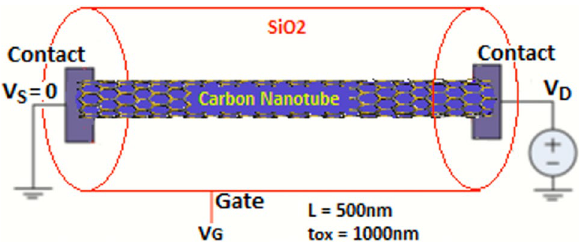
Figure 1. A schematic of the modeled gate-all-around (GAA) device. The work function difference between the ideal gate metal and the CNT is assumed to be